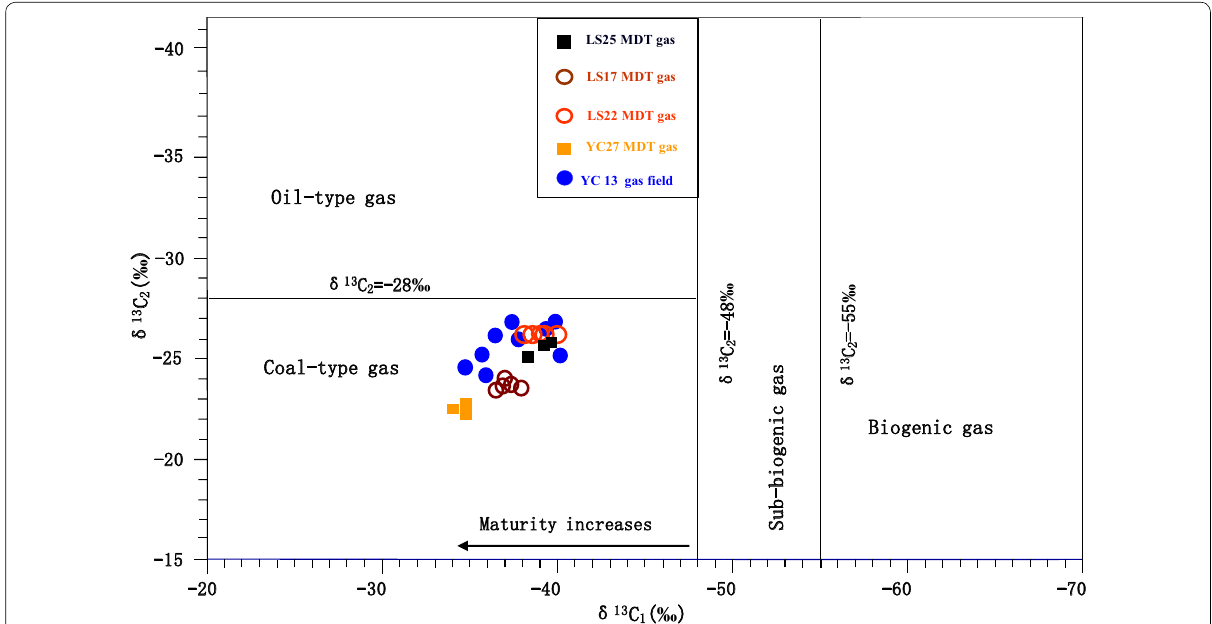
Fig. 9 The relationship between methane and ethane isotopes and gas genetic types in western Qiongdongnan